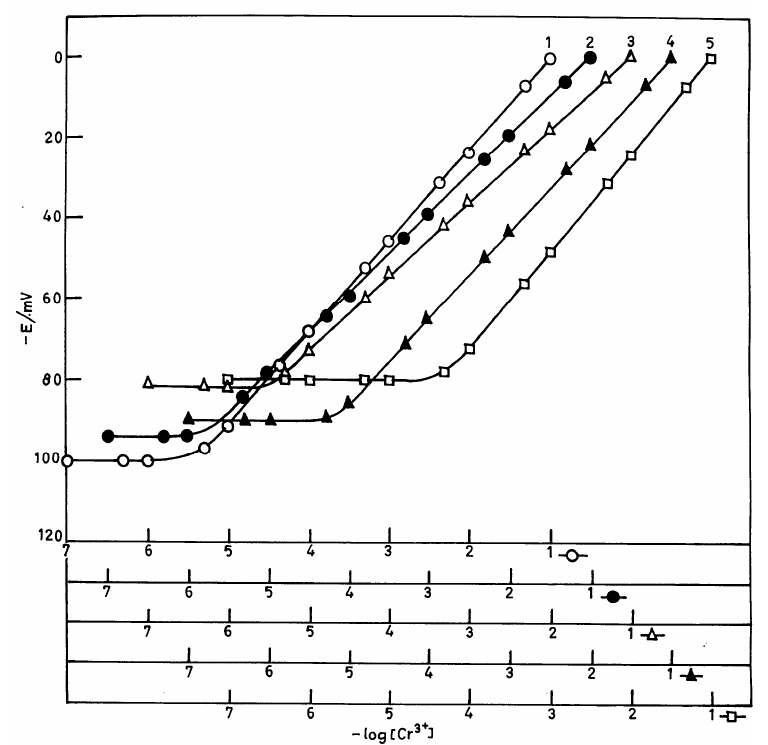
Figure 1. Plots showing the variation of the membrane potential of different macrocyclic ligands with the concentration of Cr(III) ions. The numbers on the plots refer to compositions given in Table